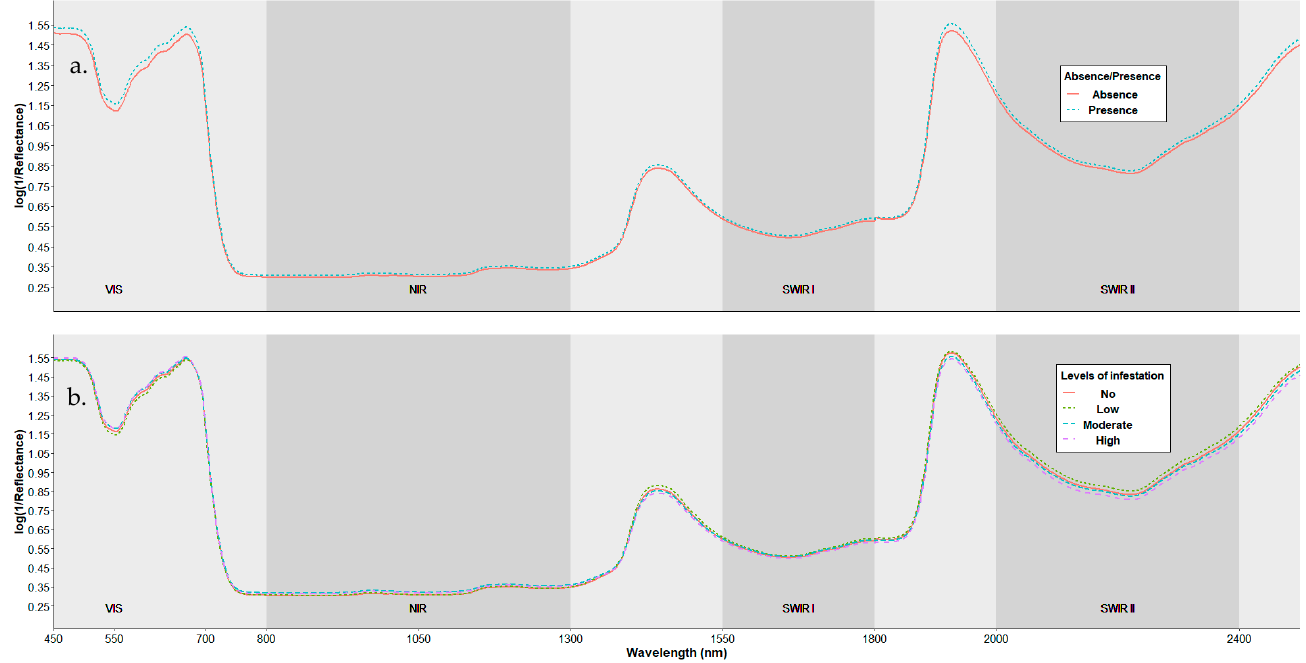
Figure 5. Spectral characterization using transformed values, based on gall absence or presence ( a ) and on different infestation levels ( b ).